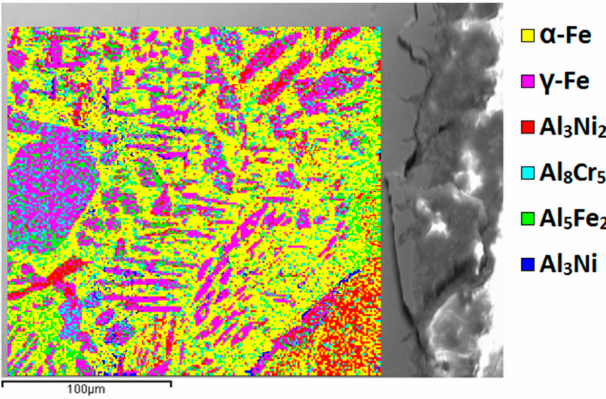
Figure 12. Scanning electron microscope electron backscattered diffraction mapping (SEM/EBSD) of the surficial aluminum-rich layers of the sample annealed at 1080 ◦ C for 360 s/mm and aluminized at 1100 ◦ C for 2700